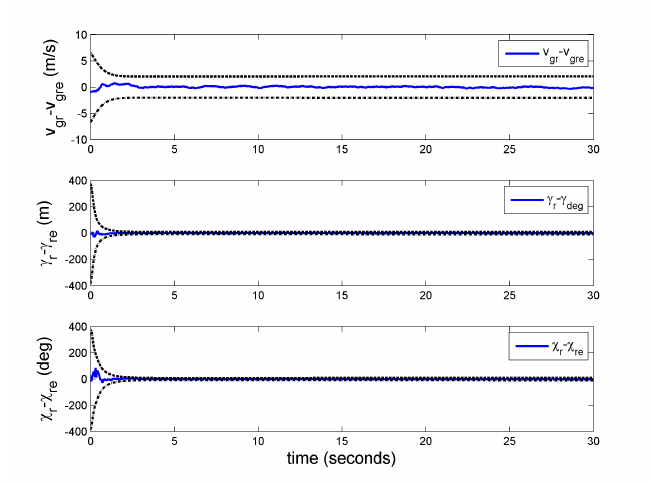
Figure 22. Position errors with 3 − σ bounds (Case 3).